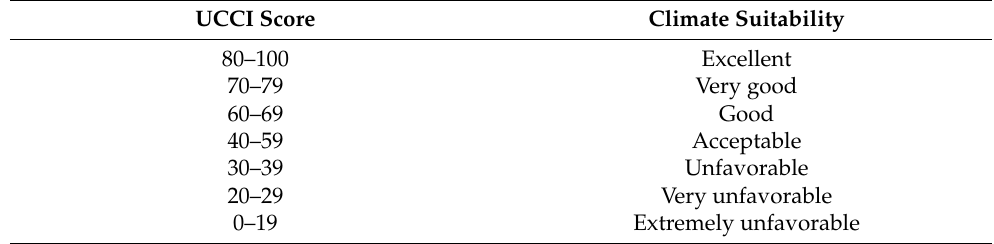
Table 3. Classification of climate suitability for an urban tourist destination based on UCCI. UCCI